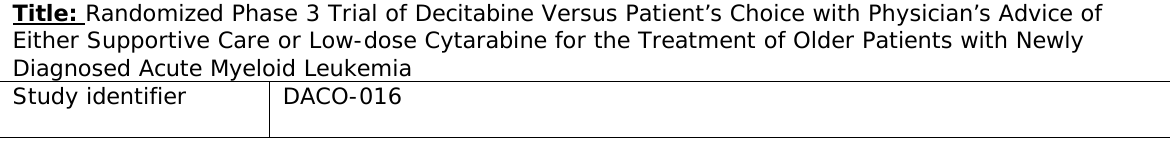
Table 20: Summary of Efficacy for trial DACO-016 Title: Randomized Phase 3 Trial of Decitabine Versus Patient’s Choice with Physician’s Advice of Either Supportive Care or Low-dose Cytarabine for the Treatment of Older Patients with